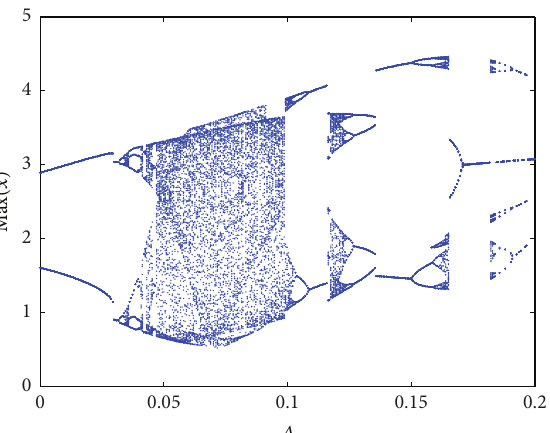
Figure 5: The bifurcation diagram in plane ( 𝐴, 𝑥 ) with 0 < 𝐴 < 0.2 , 𝑚 = 0.3 , 𝑏 = 0.2 , 𝑑 = 0.8 , 𝑐 = 0.25 , 𝛽 = 2.4 , 𝛼 = 1.7 , ℎ = 1.2 , and 𝜔 = 0.6 .